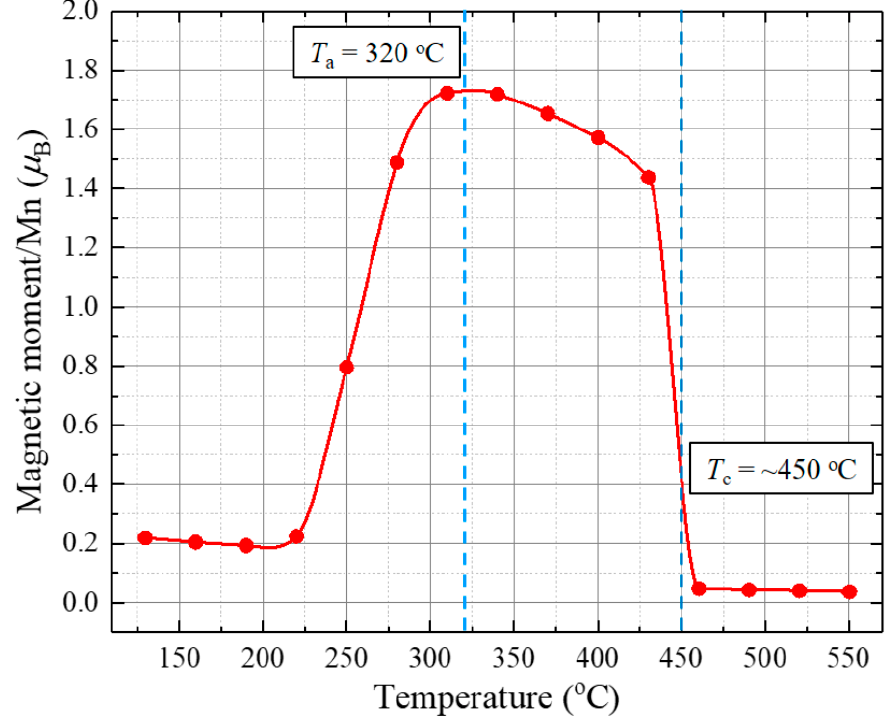
Figure 3. Temperature dependence of the magnetic moment per Mn atom of an amorphous Mn 56 Bi 44 bulk sample under an applied magnetic field of 2.5 T.